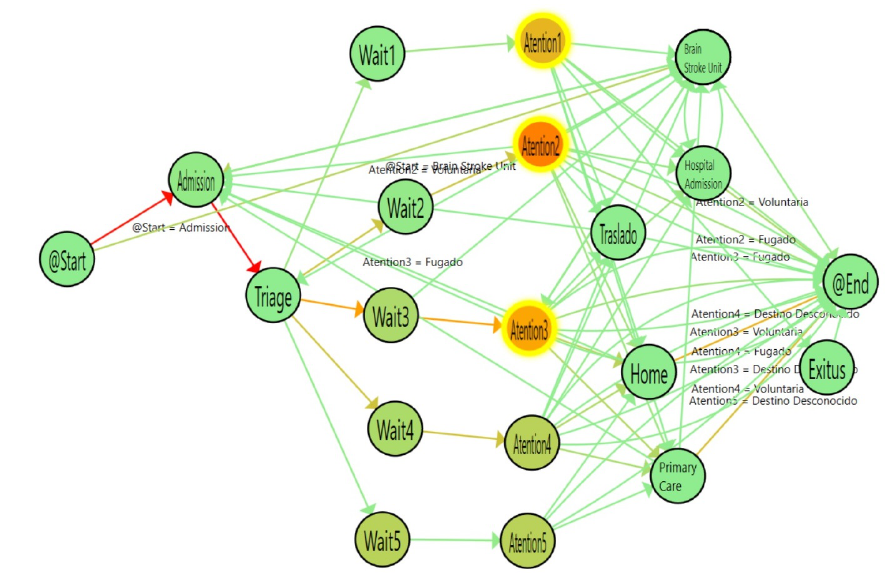
Figure 11. Emergency Room Flow determined for patients from 40 to 65 years old. Highlighted Nodes indicate a statistically significant difference compared with patients age 65+